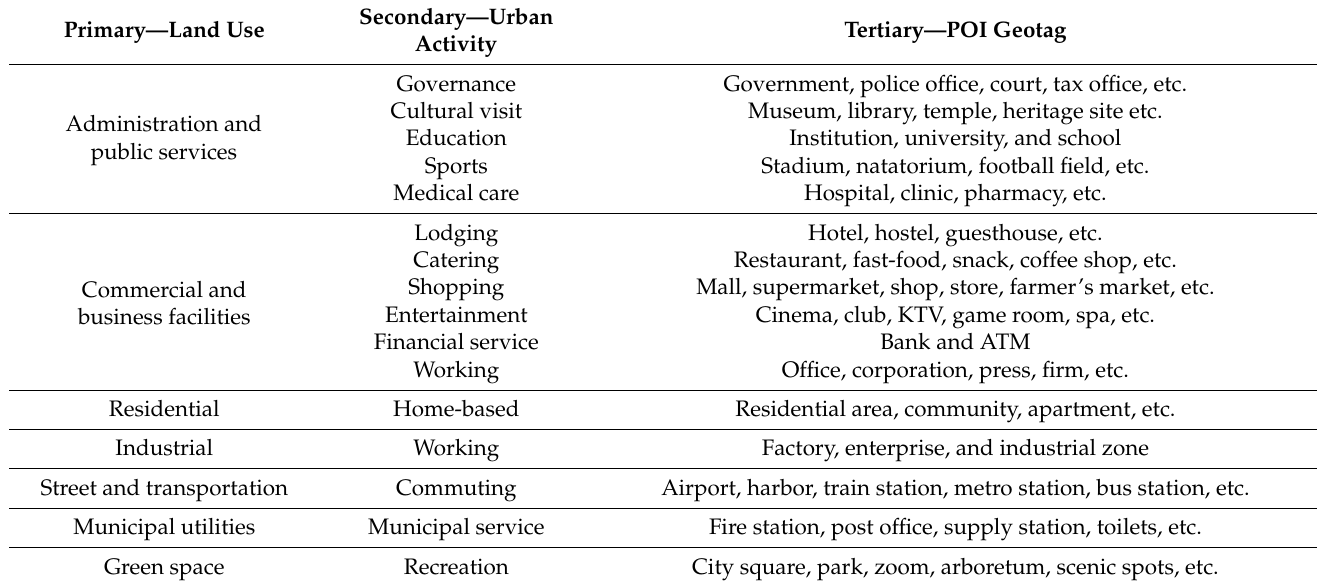
Table 2. The three-tier classification